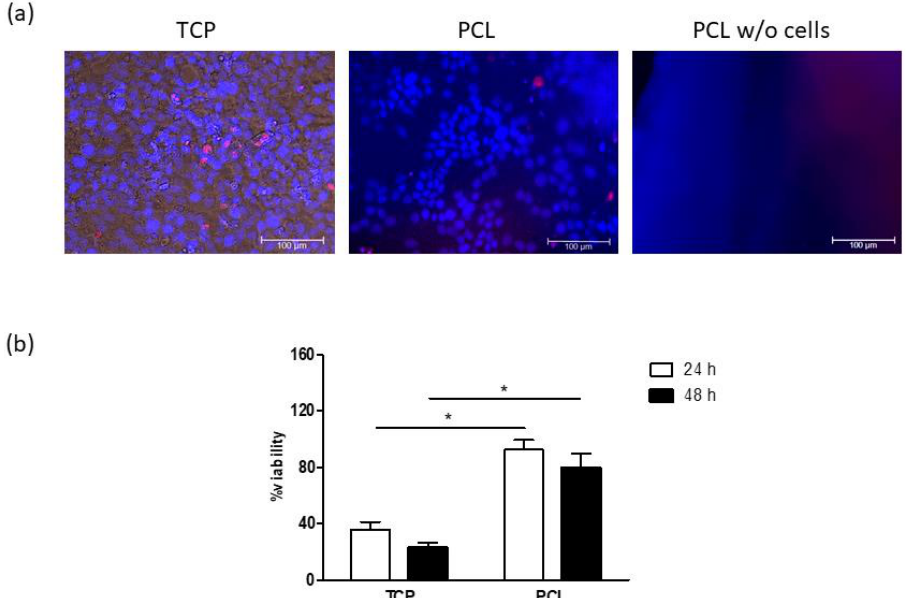
Figure 7. ( a ) Representative images of cultures at 15 min of doxorubicin treatment: nuclei and doxorubicin are blue and red, respectively. Bars: 100 µ m. ( b ) Cell viability after 24 and 48 h exposure periods to 5 µ M doxorubicin. Results are reported as percentage from the corresponding non-treated cultures. * p < 0.05 vs. cultures grown on tissue-culture polystyrene (TCP); Student’s t test.